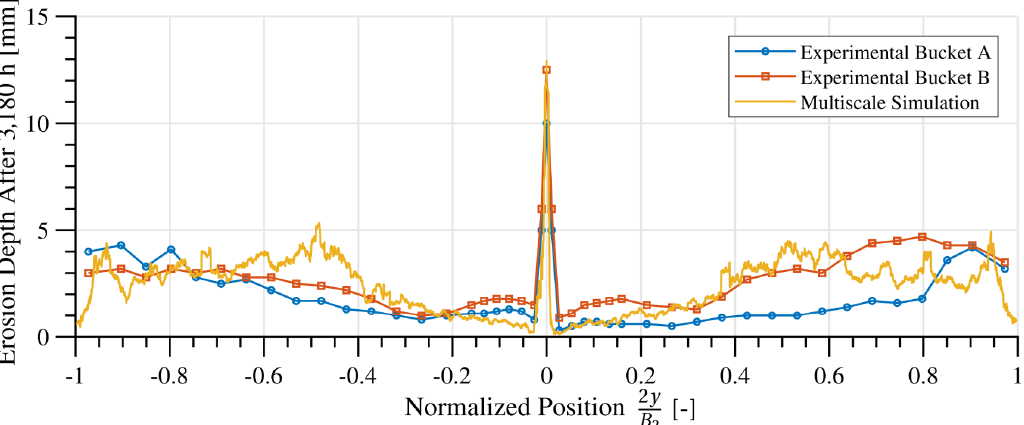
Figure 5. Eroded depth distribution on the pitch diameter position after 3180 h of operation; the multiscale simulation results compare well with the corresponding experimental data of Rai et al.